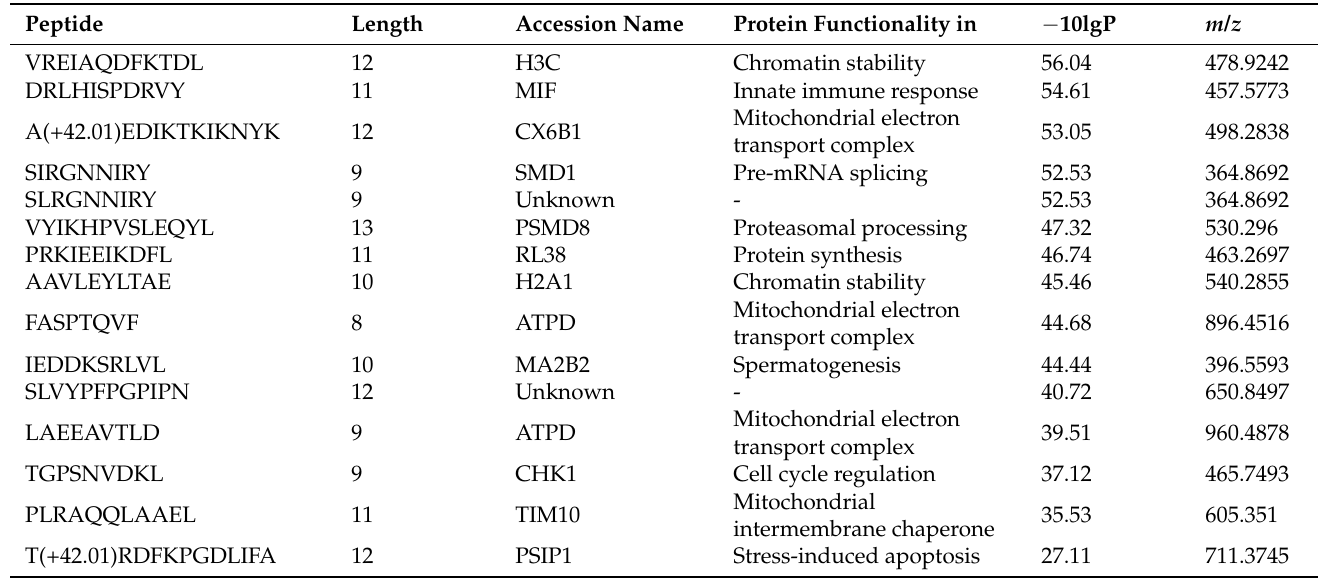
Table 3. Fifteen peptides commonly being presented by all EL4 cell types excluding EL4-vector cells. Numbers in brackets indicate the increase in amino acid mass due to possible post translational